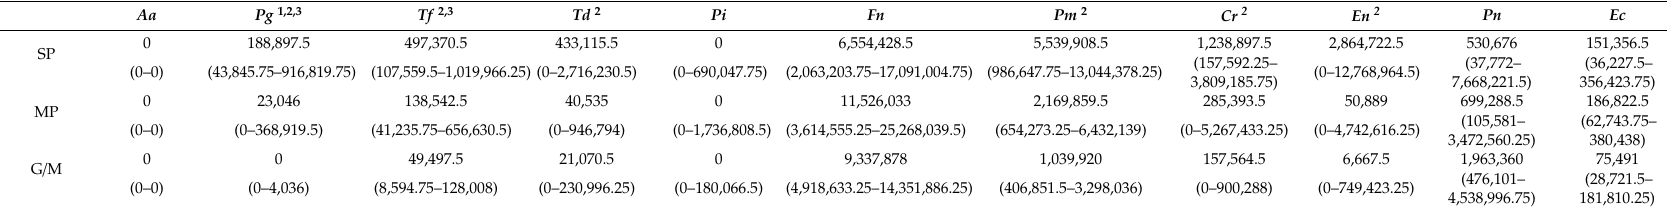
Table A3. Bacterial DNA counts of target bacteria in mouthwash samples of di ff erent study groups. Median values and interquartile ranges were summarized in the